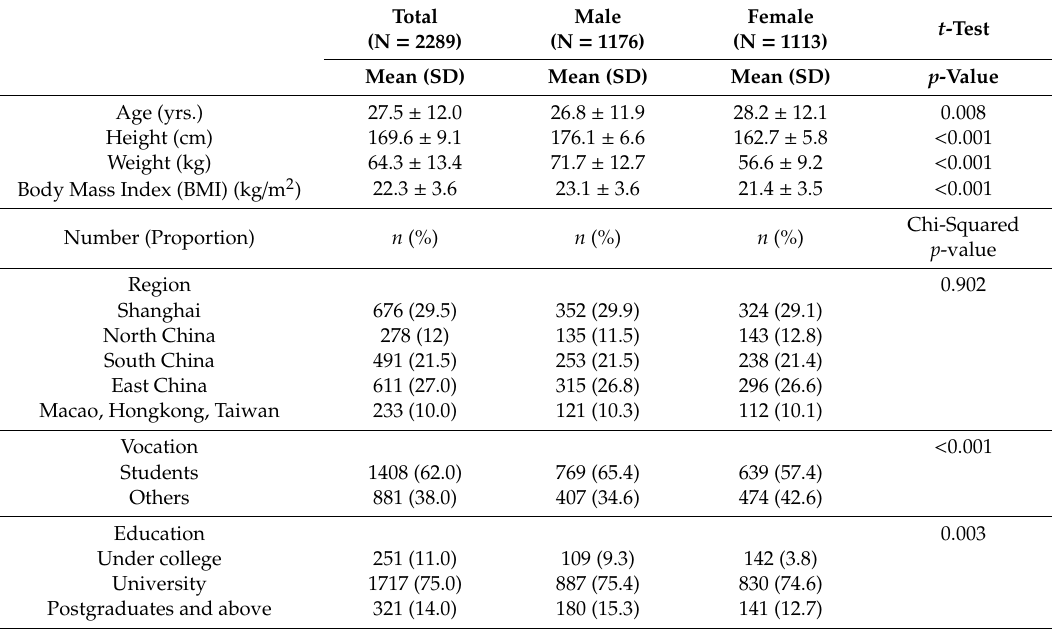
Table 1. Participant demographic and descriptive characteristics by gender.